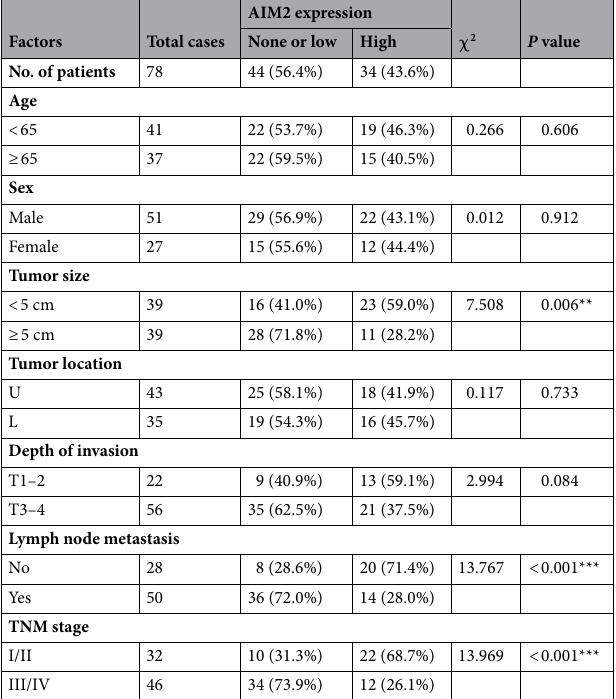
Table 1. The association of AIM2 expression with clinicopathological features in 78 gastric cancers. ** P < 0.01, *** P < 0.001.